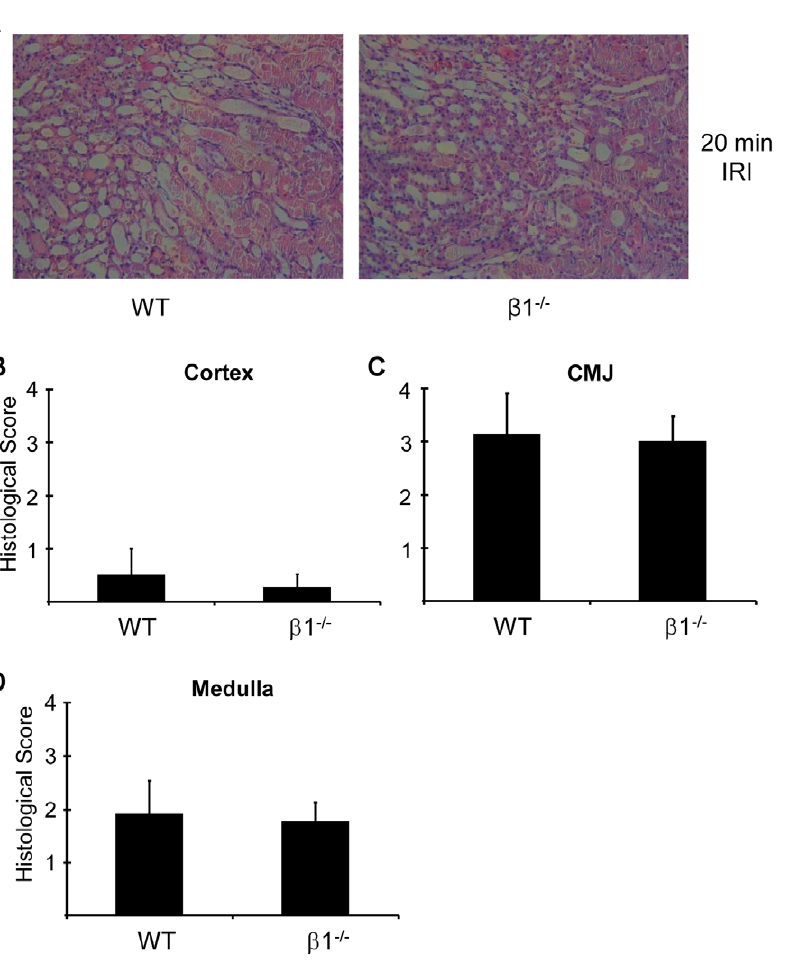
Figure 4. Histological injury 24 hours after renal ischemia-reperfusion injury in wild type and AMPK- b 1 2 / 2 mice. IRI was performed for 20 minutes and the severity of injury was assessed by histology. A. Histological appearance at 24 hours following 20 mins IRI in WT and b 1 2 / 2 mice. Images shown are from the region of the corticomedullary junction (CMJ). 200 6 magnification. The severity of histological injury at 24-hours was quantified in cortex (B), CMJ (C) and medulla (D) as described in methods. No differences were seen between WT and b 1 2 / 2 mice. n=7 for WT and 6 for b 1 2 / 2